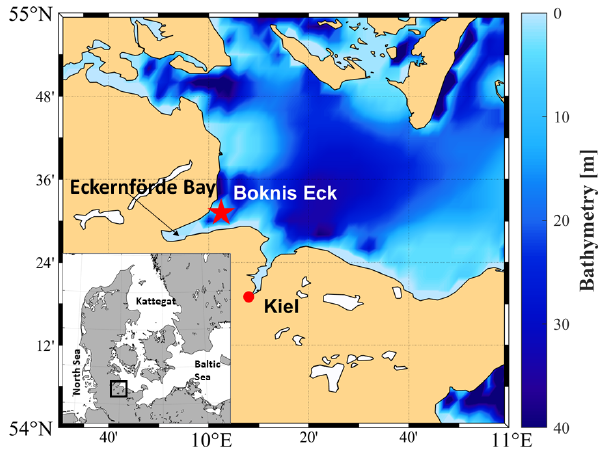
Figure 1. Location of the Boknis Eck Time Series Station near the entrance of Eckernförde Bay in the southwestern Baltic Sea. The location map was created with the m_map package for MATLAB R2019 (Pawlowicz,